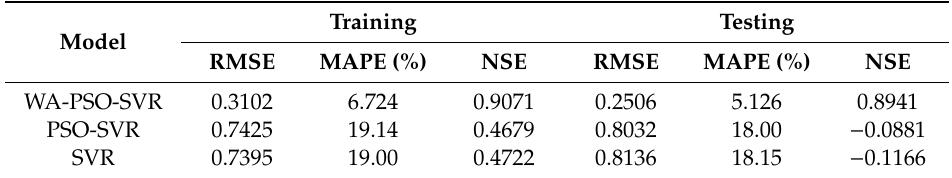
Table 5. Statistical values of monthly COD Mn prediction in the training and testing phase.